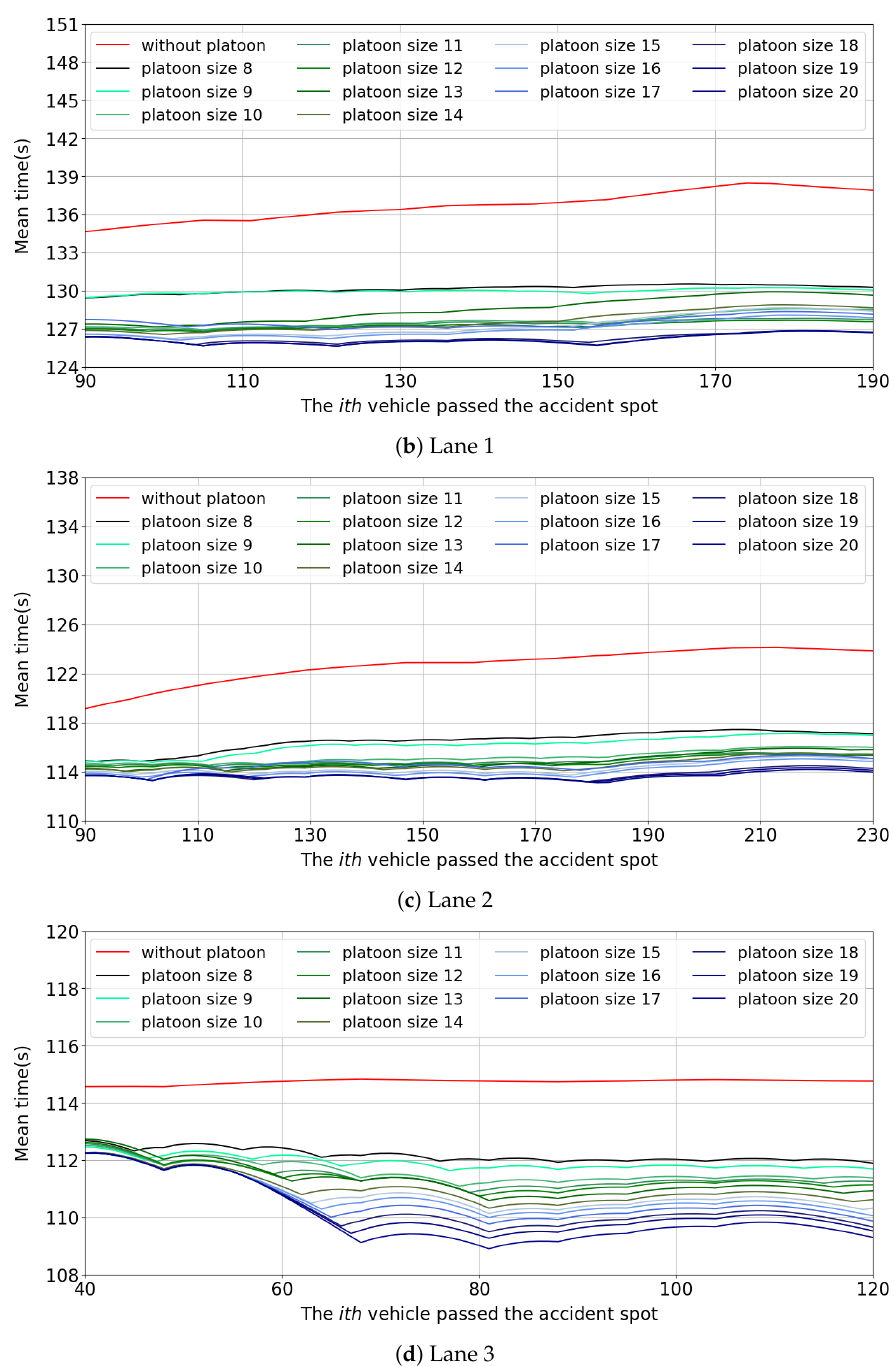
Figure 6. The mean time taken for the vehicles to exit the congestion spot if they receive an accident warning 3500 m ahead of the accident